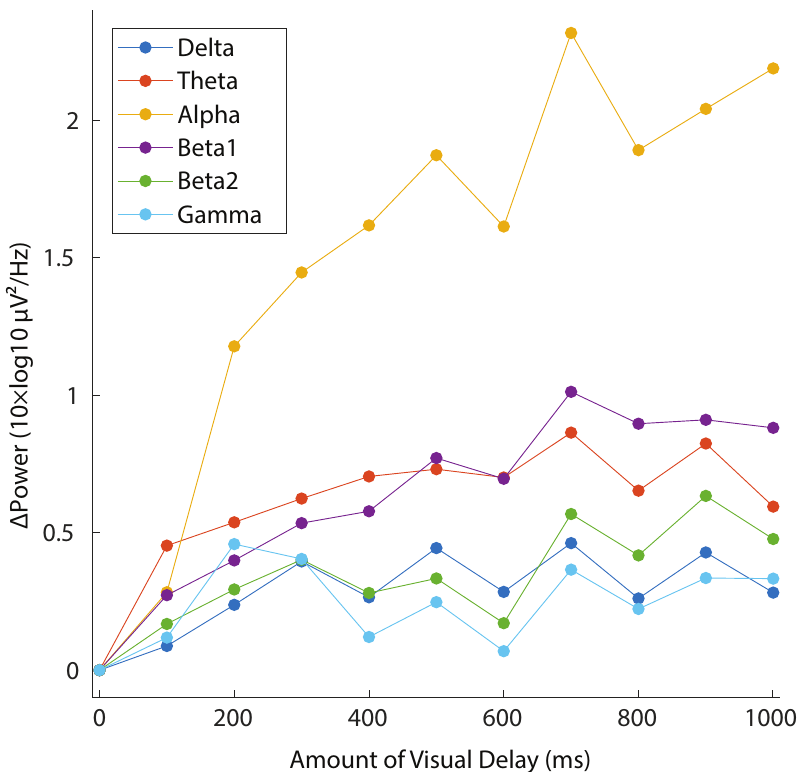
Figure 5. Global EEG power (i.e., mean across all scalp electrodes) changes to increasing amount of visual delay for each frequency band. The changes are relative to no delay condition (0 ms). The alpha-band power showed the most sensitive changes to the increase of visual delay.